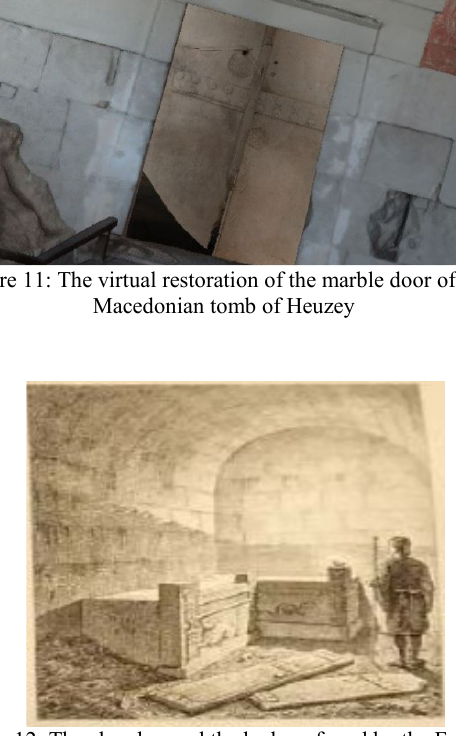
Figure 12: The chamber and the beds as found by the French in 1861in the tomb of Heuzey